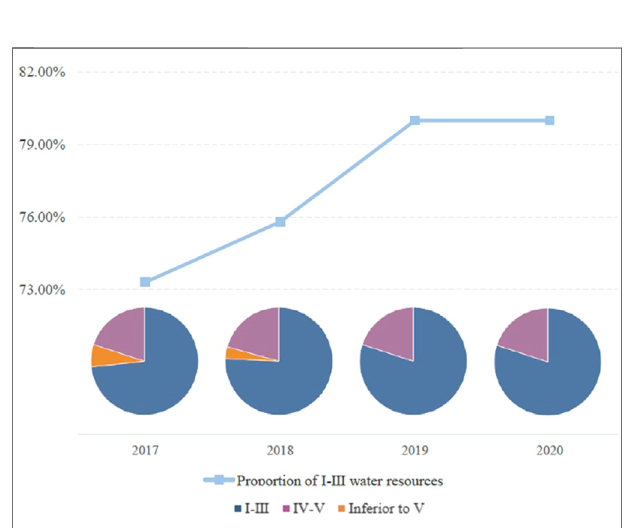
FIGURE 5 | Proportion of surface water with different water quality from 2017 to